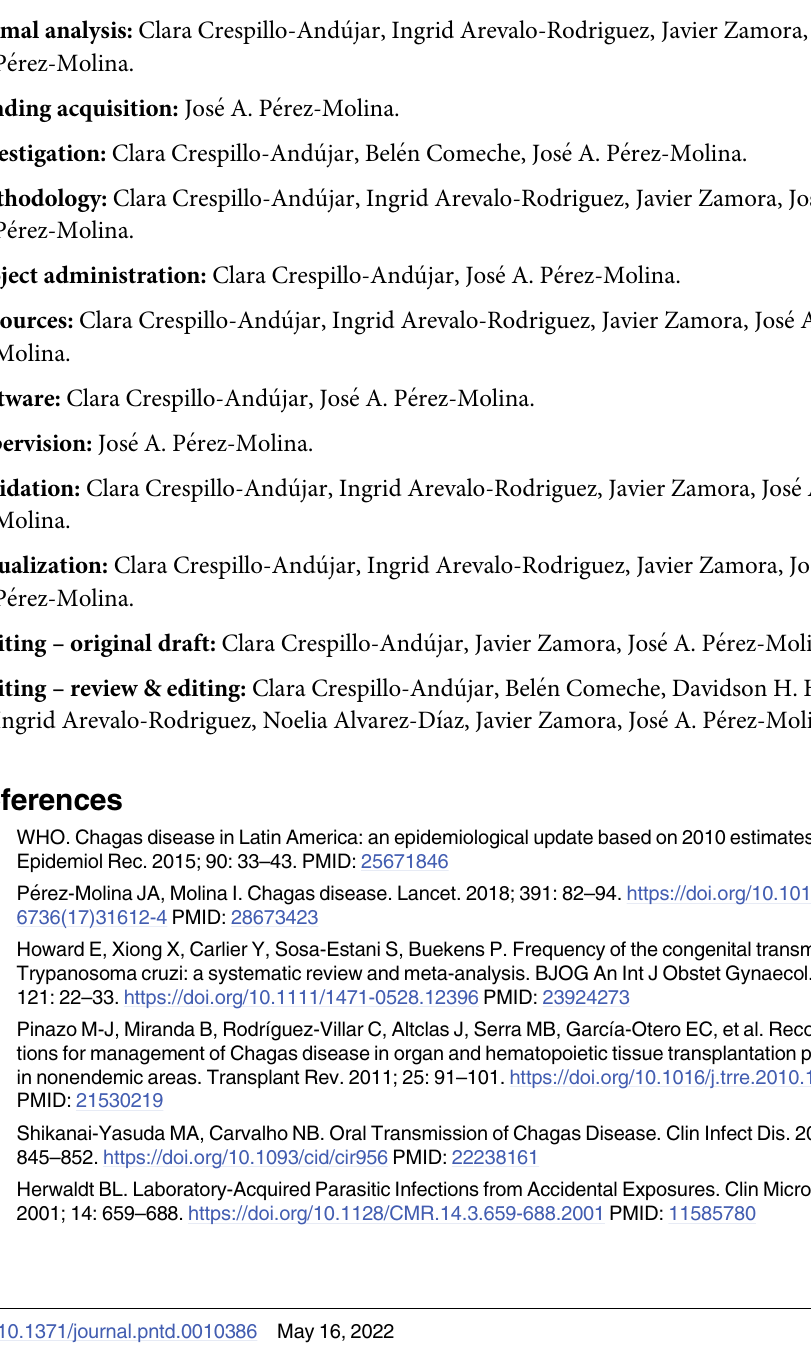
S6 Fig. Evaluation of the effect of benznidazole compared with placebo or no treatment on the response to therapy in adult patients according to secondary parasitological endpoint by type of study (only in those with > 60 months follow-up period). RCT: Randomized